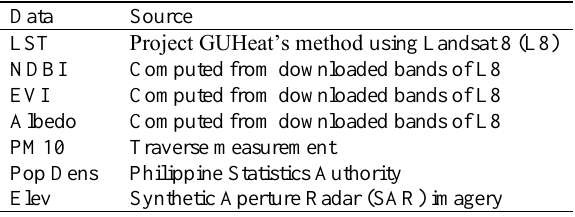
Table 1. Data summary for regression